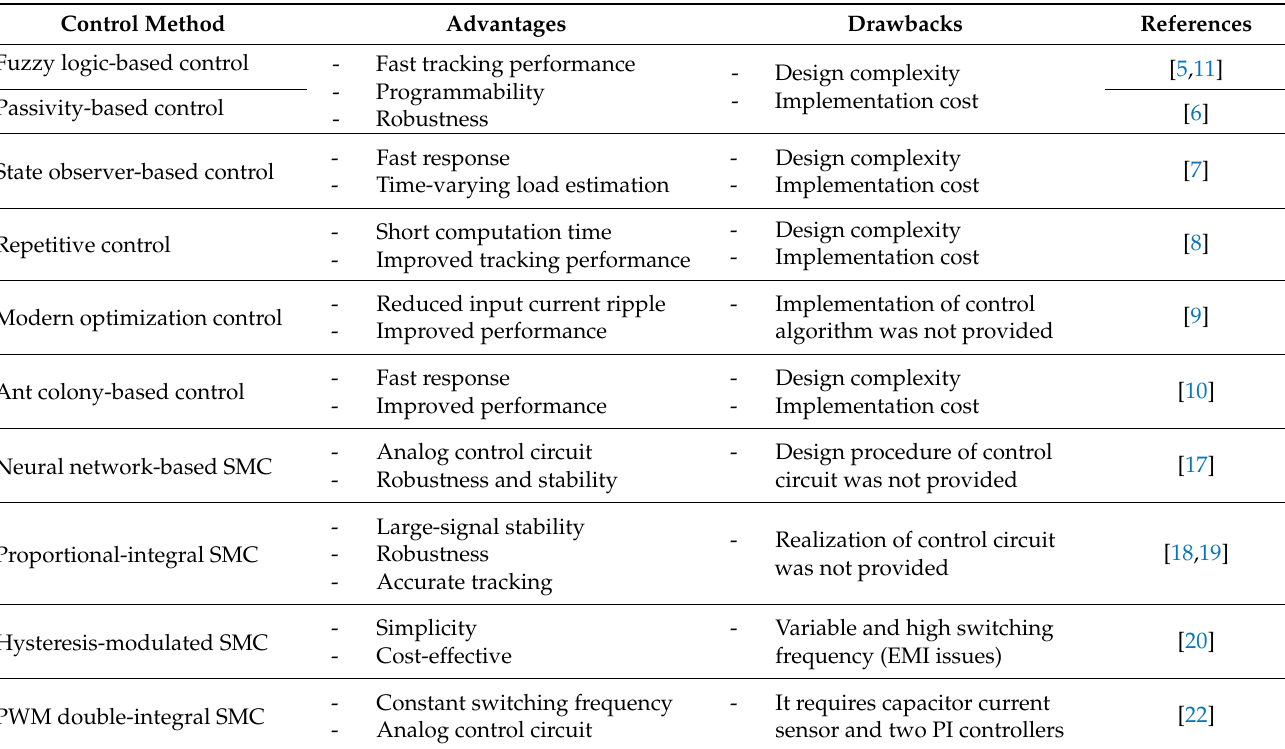
Table 1. Summary of modern control applications of a DC-DC Cuk converter.